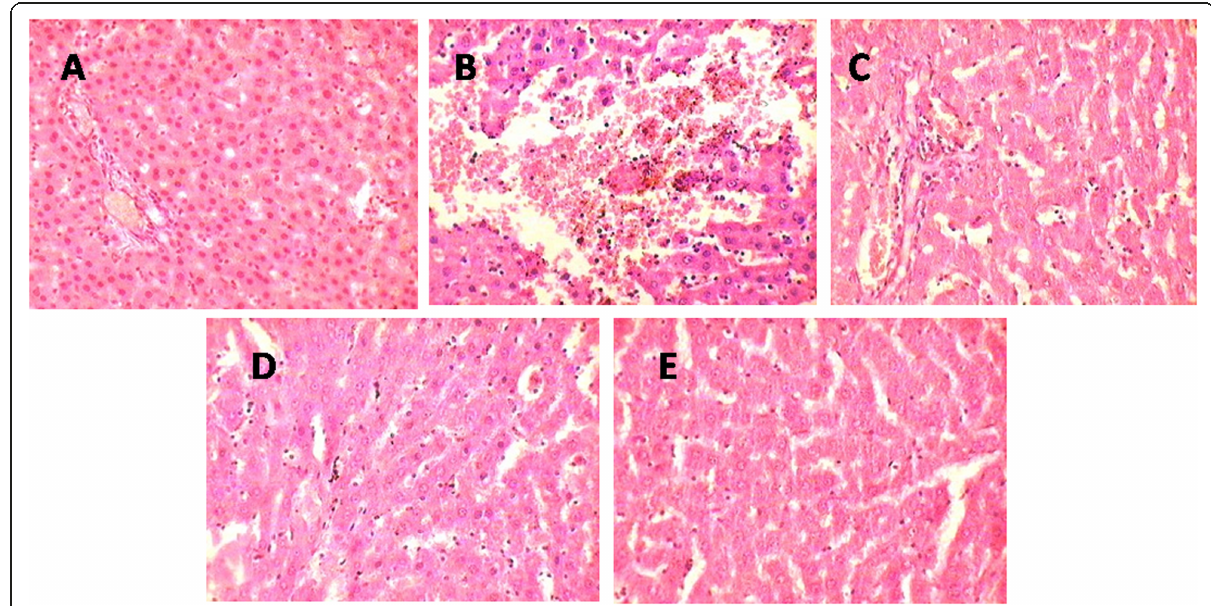
Fig. 2 Antihepatotoxic activity of BNF-LCME against D-Galactosamine induced hepatotoxicity in rats. Done by using Digital Motic